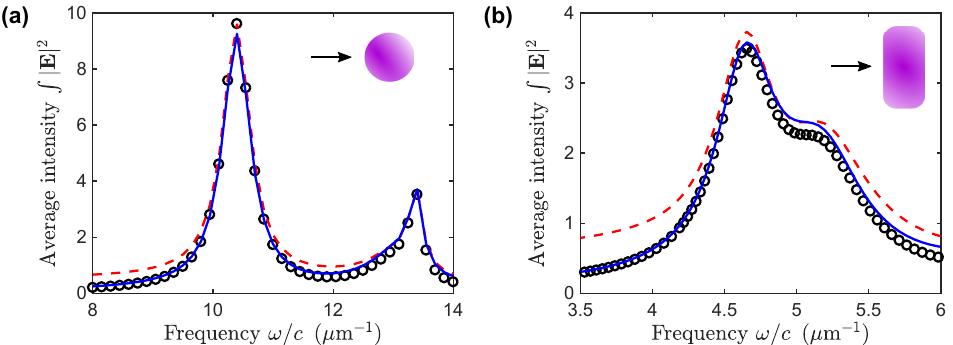
Figure 5. Field reconstruction with a specific computation of the static modes. ( a ) Dielectric nanosphere of Section 3.2. ( b ) Dielectric nanodisk with rounded edges. The average intensity enhancement inside the resonator is plotted as a function of the frequency, ( 1/ V res ) Blue curve: QNM expansion with separately computed static modes; Red dashed curve: QNM expansion without static modes; Black circles: direct FEM